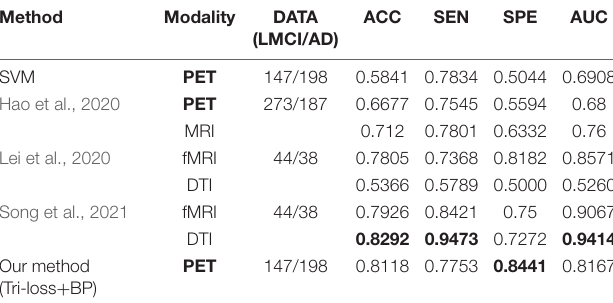
TABLE 10 | Comparison of the performance of different model algorithms in experiments for LMCI vs. AD classification with the related works. Method